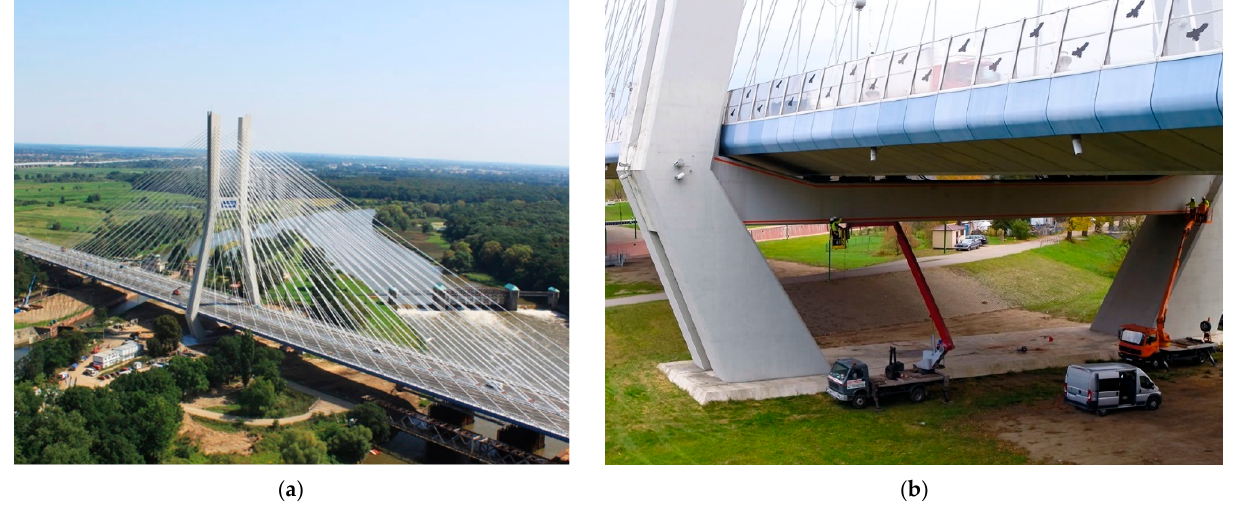
Figure 19. ( a ) R ę dzi ń ski Bridge in Wroc ł aw, Poland—general view (photo: W. Kluczewski); ( b ) the Figure 19. ( a ) R˛edzi´nski Bridge in Wrocław, Poland—general view (photo: W. Kluczewski); ( b ) the close-up of the lower crossbeam connecting two inclined legs of the pylon. close-up of the lower crossbeam connecting two inclined legs of the